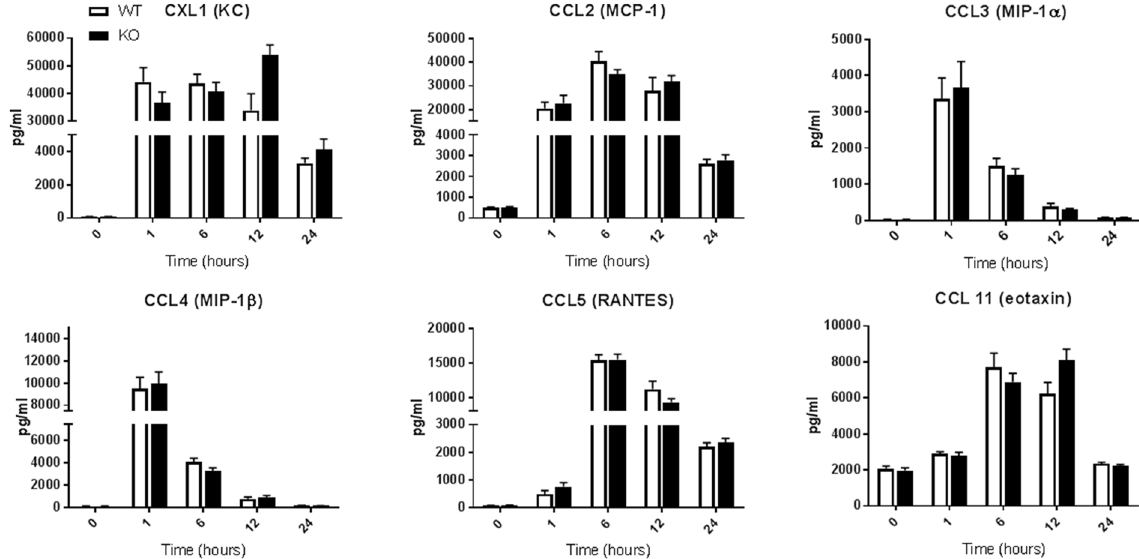
Figure 6. Serum chemokine levels in WT and ficolin KO mice after LPS challenge with a sublethal dose. Groups of WT and ficolin KO mice were intraperitoneally injected with LPS of a sublethal dose (2.5 mg/ kg). At indicated time points, blood was collected before the mouse was sacrificed. The serum concentration of chemokines was measured by a multiplex Luminex assay; the data was obtained from two independent experiments per time point and represent mean ± SEM (n = 11 mice per group per time